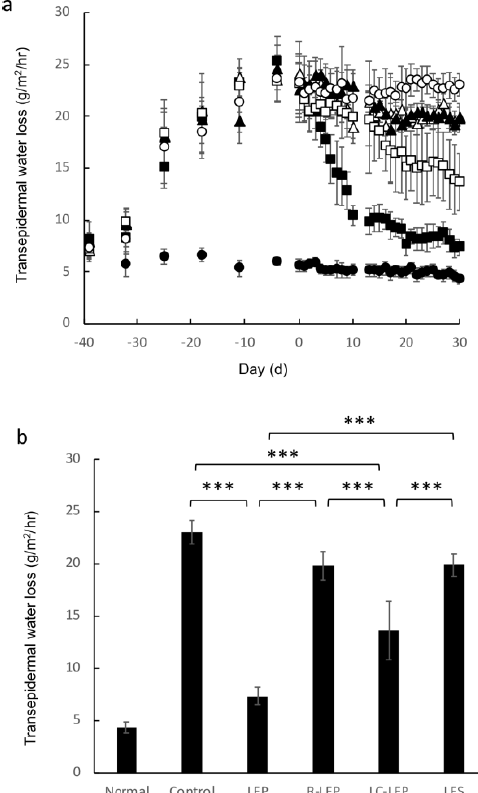
Figure 4. Transepidermal water loss in regular and HR-AD-fed mice after oral administration of lactic acid bacteria metabolites over time ( a ), and after 40 days ( b ). Data represent mean and standard deviation ( n = 4 to 6). * p < 0.05, *** p < 0.001 (Tukey’s post-hoc test) . Symbols: closed circle, normal (regular diet fed, distilled water); open circle, control (HR-AD fed, 10.8% ethanol in water);